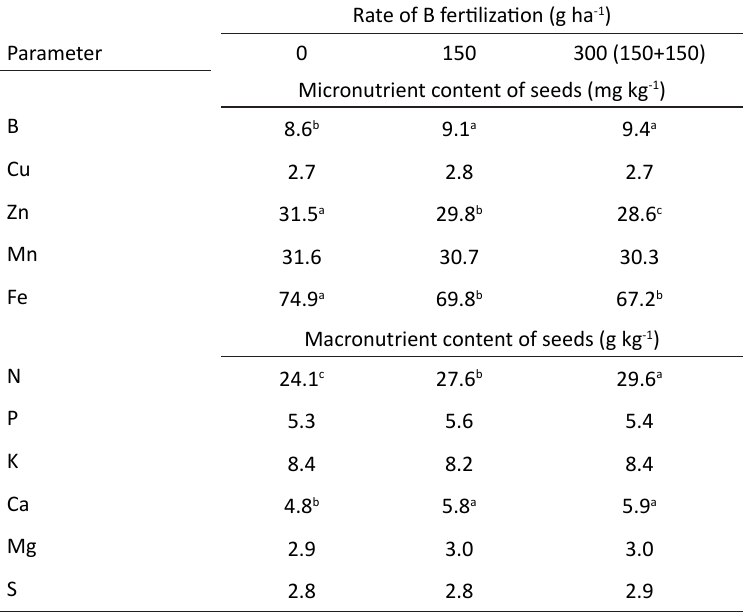
Table 6. The effect of foliar B fertilization on the nutrient content of seeds of winter oilseed rape (across years)